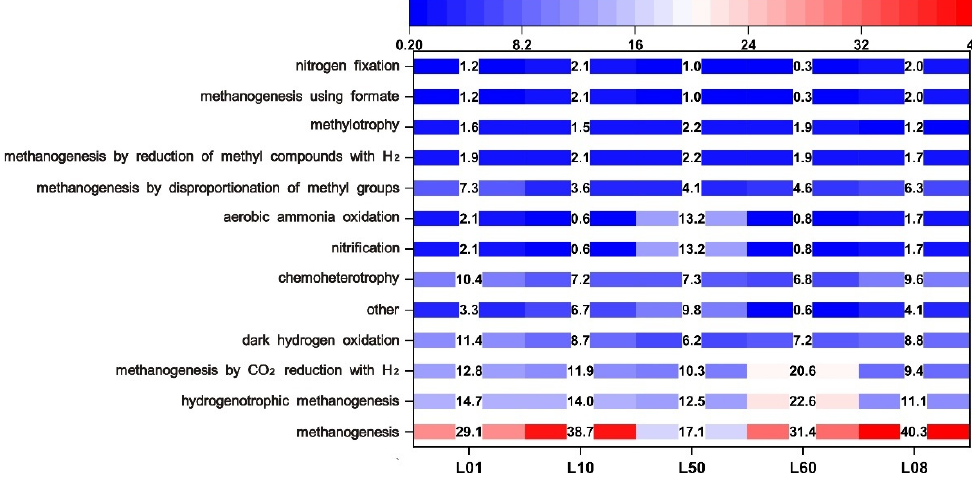
Figure 5. Heat map illustrating function prediction of archaeal community. The numbers are the abundance of the functions in %.